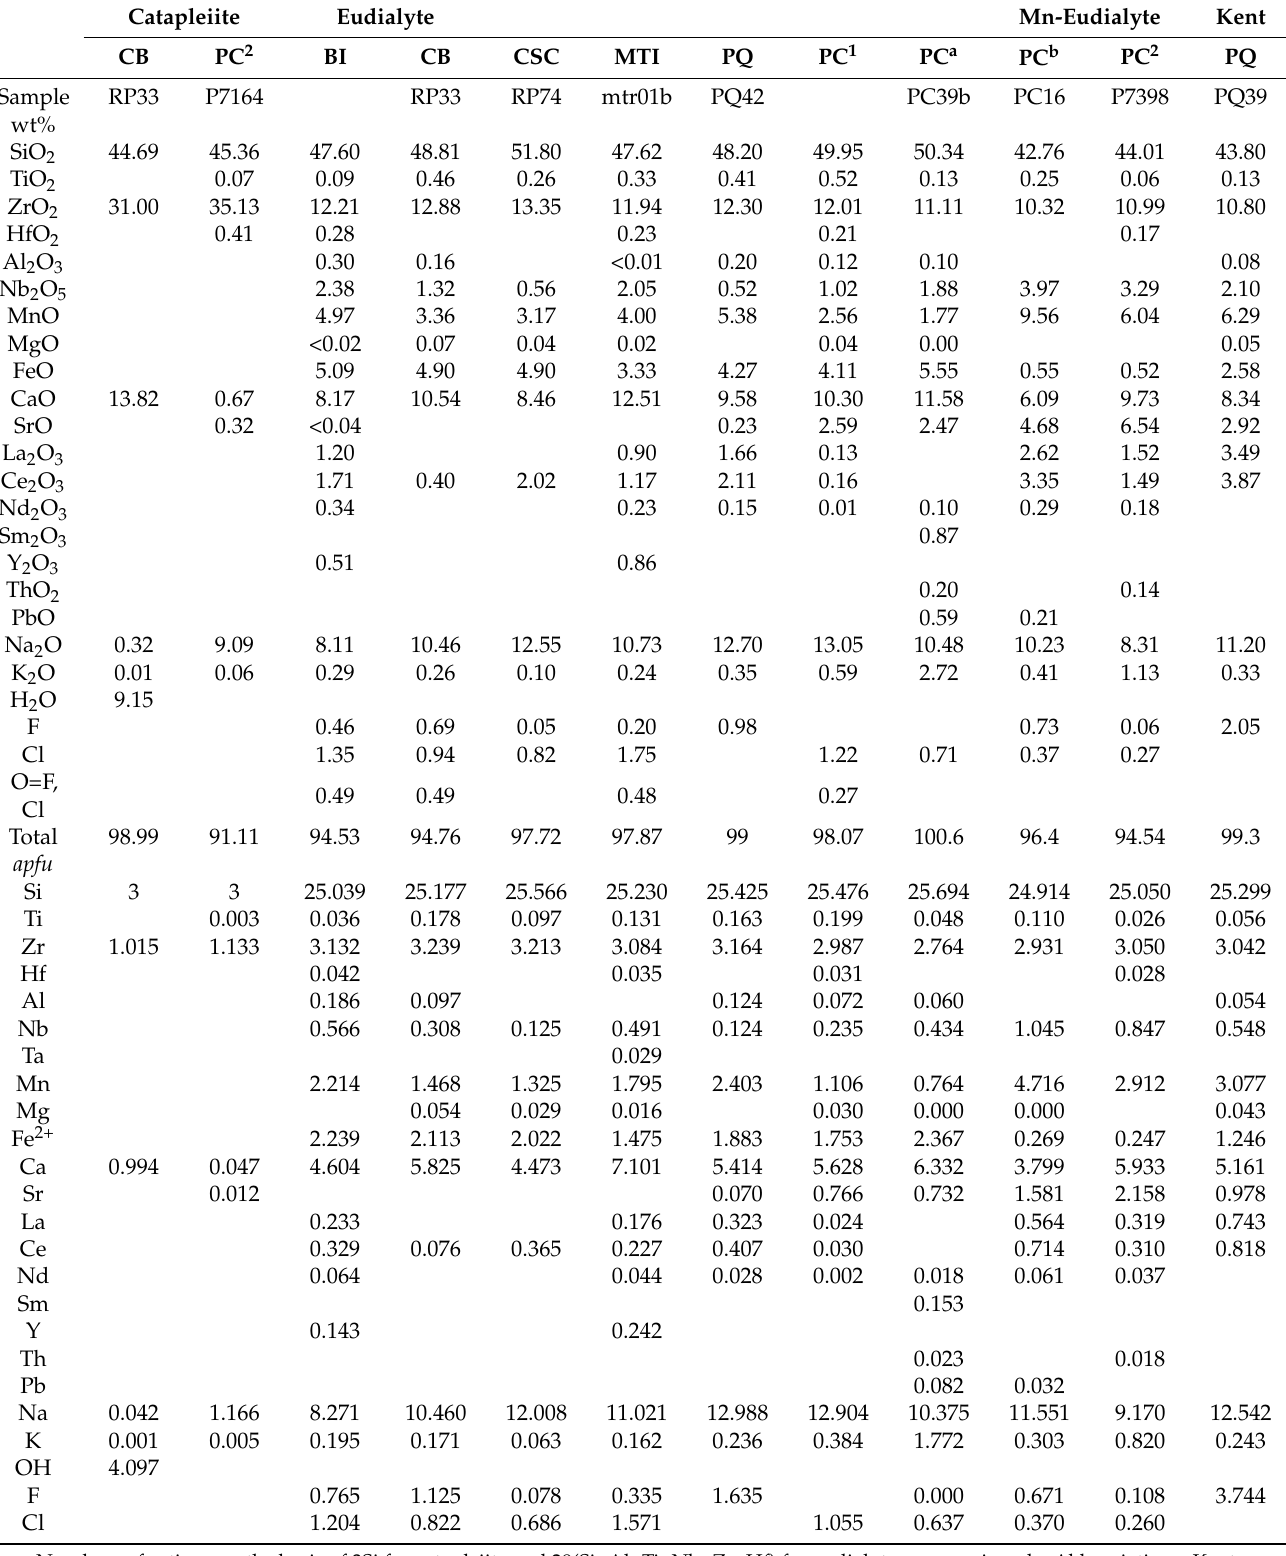
Table 5. Cyclosilicate